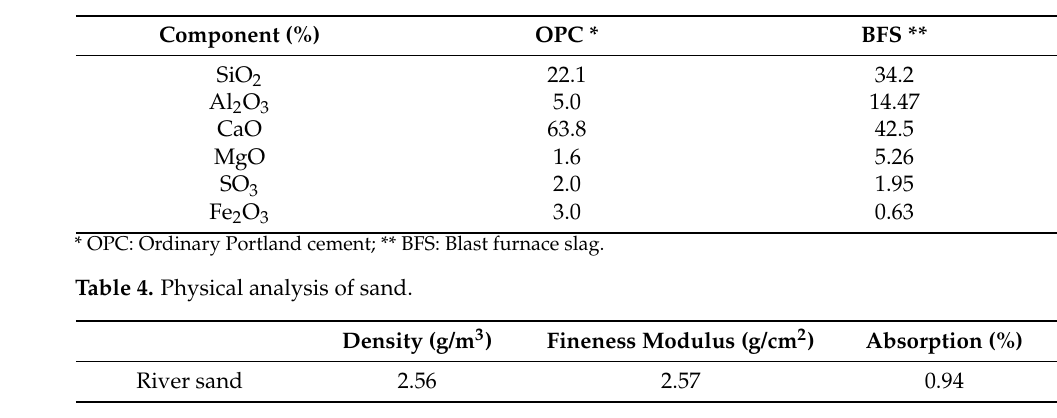
Table 3. Chemical composition of cement and blast furnace slag.